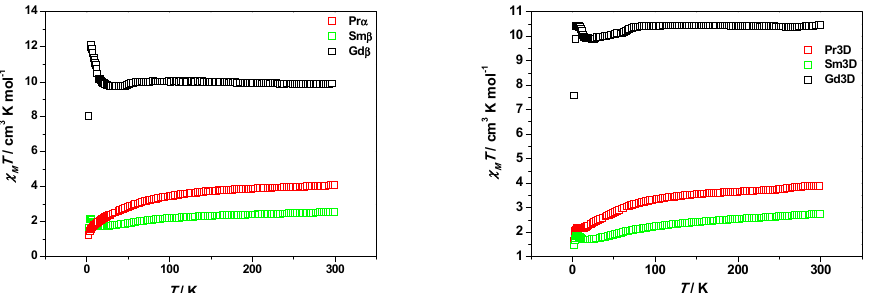
Figure 8. Plots of the χ M T vs. temperature for compounds Pr α , Sm β , Gd β ( left ) and Pr3D , Sm3D and [Gd(H 2 O) 4 ][Ru 2 (CO 3 ) 4 (H 2 O) 2 ] · 2.5H 2 O ( Gd3D ) [21] ( right ).